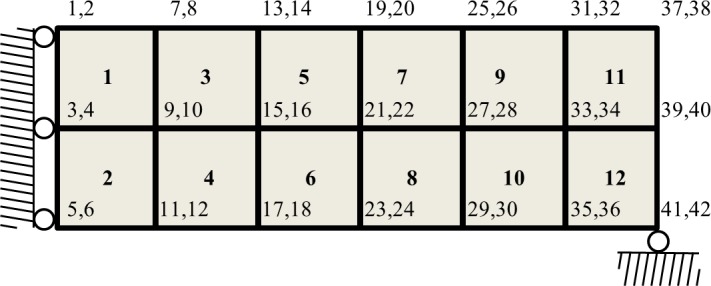
Numbering of DOF, nodes, and elements in right half of the MBB beam: starting from top-left and proceeding in column-wise order.